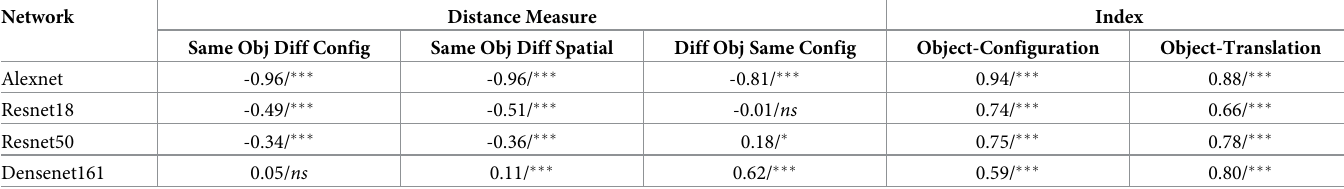
Table 7. Correlation coefficients of Euclidean distance and index measures comparing configuration and uniform translation manipulations.